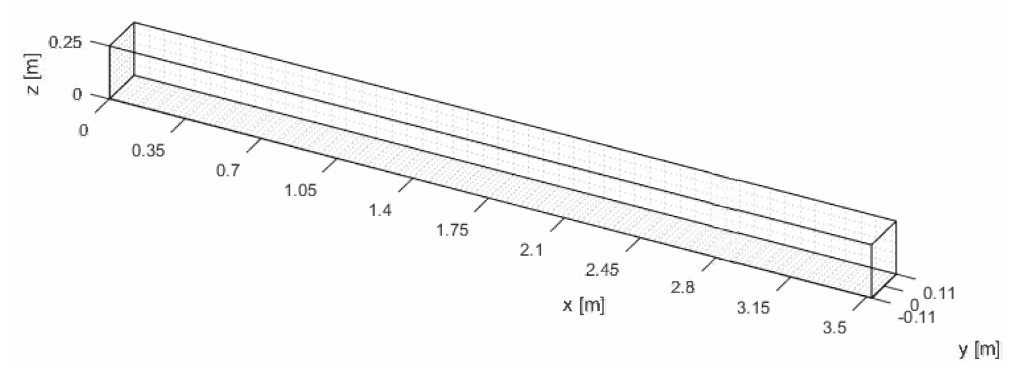
Figure 4. Geometry used in all numerical simulations: ∆ x = 2 mm–5 cm, ∆ y = 2 mm and ∆ z = 0.5 mm; the current travels from left to right and sand particles are removed from x = 1.8 m